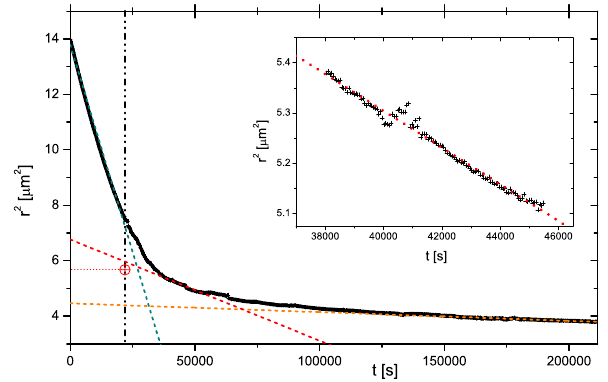
Fig. 9. Evaporation rate of a succinic acid particle at T = 298 . 5K, RH ∼= 50%. Black crosses are the data obtained from optical res- onance spectroscopy (Zardini et al., 2009, 2010). The parti- cle effloresces at t = 22000s (indicated by the vertical dashed- dotted line), the phase transition is determined from 2-dimensional angular scattering data, not shown here (for details see Zar- dini et al., 2009, 2010). Linear fits to data points for the 2 = 2 . 99 × 10 − 4 µm 2 s − 1 (dashed blue line). liquid state yield dr dt For the solid, the data between 38ks and 46ks yield a rate of dr 2 = 3 . 65 × 10 − 5 µm 2 s − 1 (dashed red line, see inset of the figure dt for details) and for the data between 150ks and 213ks we obtain a 2 = 3 . 16 × 10 − 6 µm 2 s − 1 (dashed orange line), see text for rate of dr dt discussion. The red circle marks the r 2 to which the particle would shrink if it lost all the water upon efflorescence immediately, see text.